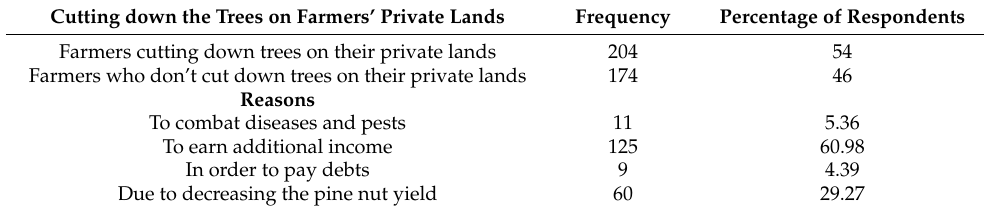
Table 9. Reasons for farmers to cut down the trees on their private lands.